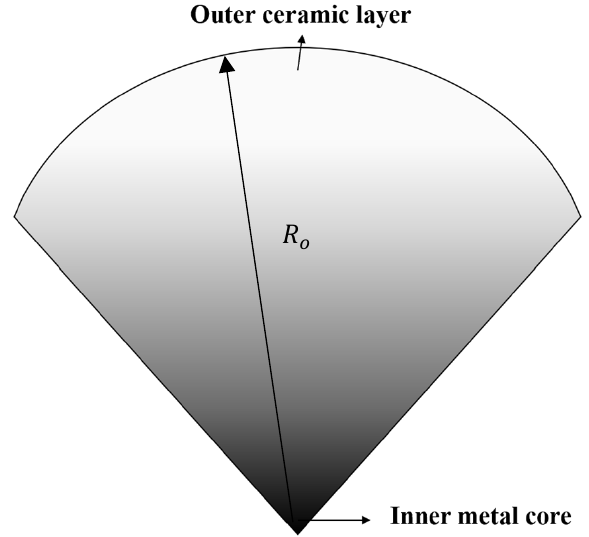
Figure 1. An EG shaft element with an inner radius 𝑅 (cid:3036) = 0.